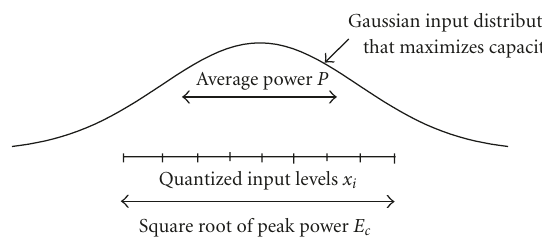
Figure 2: Peak power of quantizer is smaller than average power